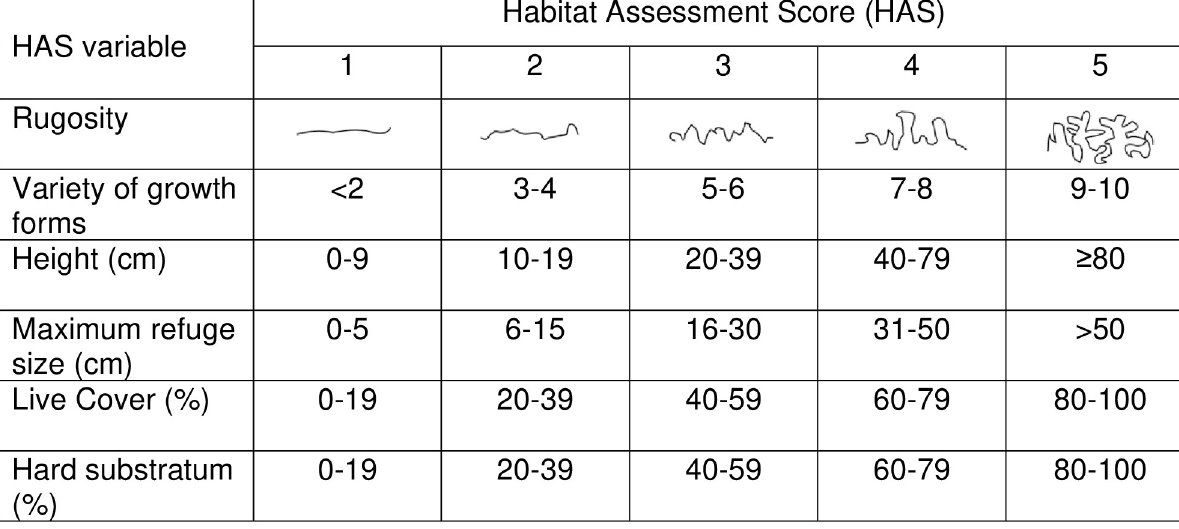
Fig 1. Habitat Assessment Score (HAS) table. This is a modified version of the HAS table [64] that indicates the criteria for each HAS value. Higher HAS values represent greater